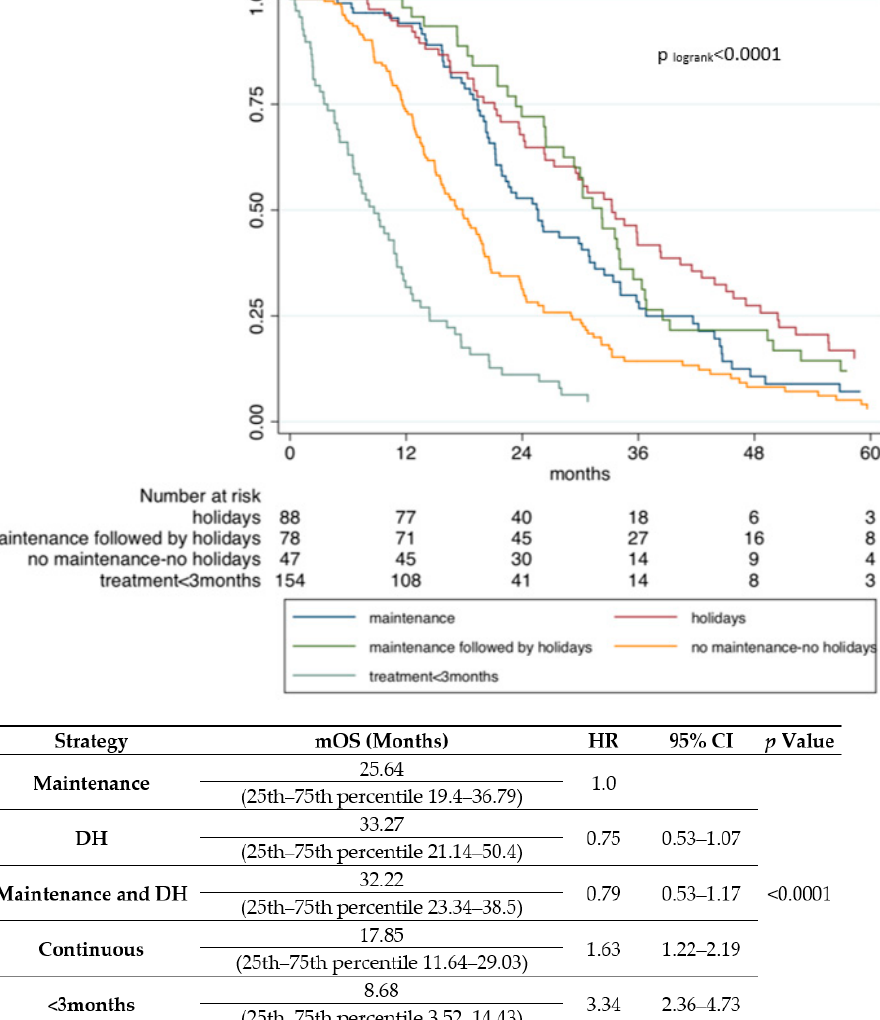
Table 3. Multivariate model for prognostic factors and Score construction. Significant associations are written in bold. Multivariate Analysis Score (Points) Variables HR 95% CI